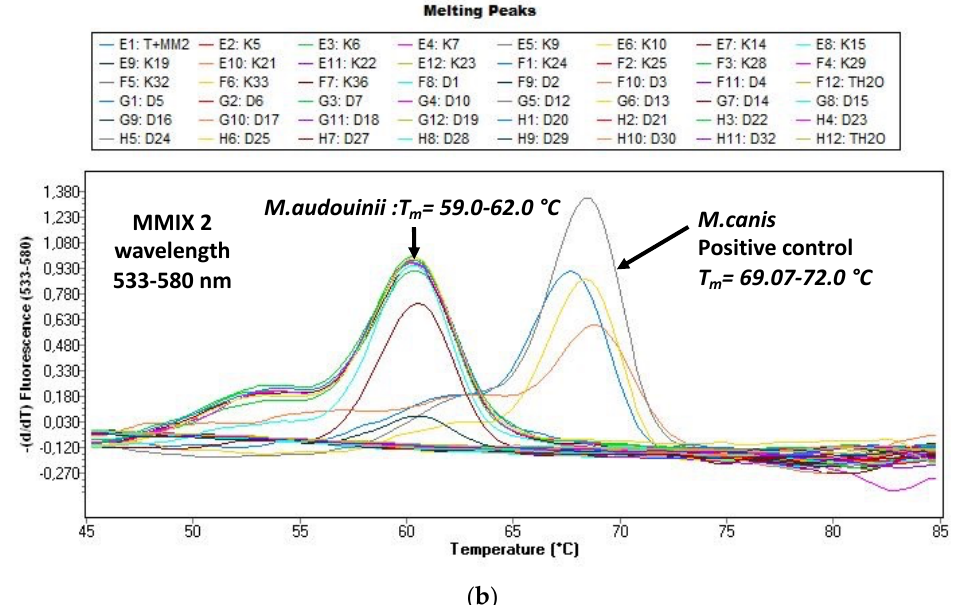
Figure 2 . ( a ) Evaluation of the melting curves, seen on the LightCycler 480 II with the real-time PCR (polymerase chain reaction) (DermaGenius ® 2.0). Delimitation Trichophyton ( T. ) violaceum and T. soudanense is possible. ( b ) Evaluation of the melting curves, seen on the LightCycler 480 II with the real-time PCR (polymerase chain reaction) (DermaGenius ® 2.0). Delimitation Microsporum (M.) canis and M.audouinii is possible.